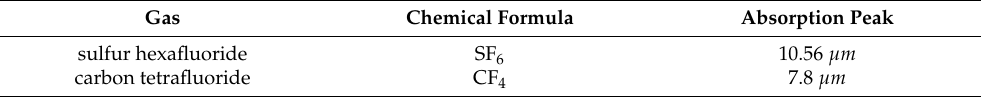
Table 4. Gas absorption